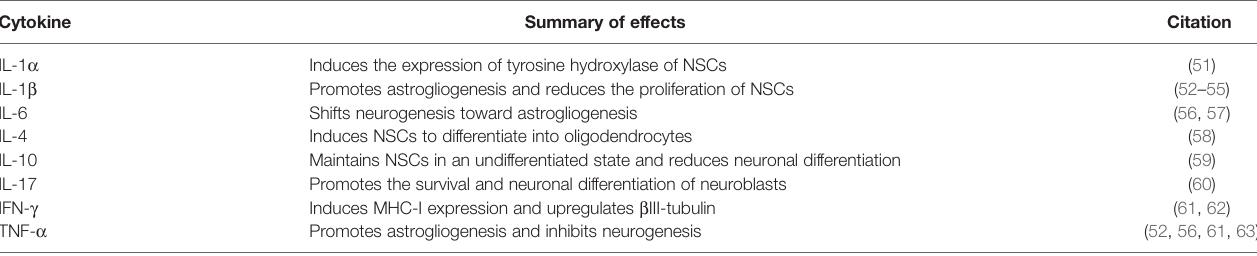
TABLE 2 | The effects of pro-in fl ammatory cytokines on neurogenesis after stroke.